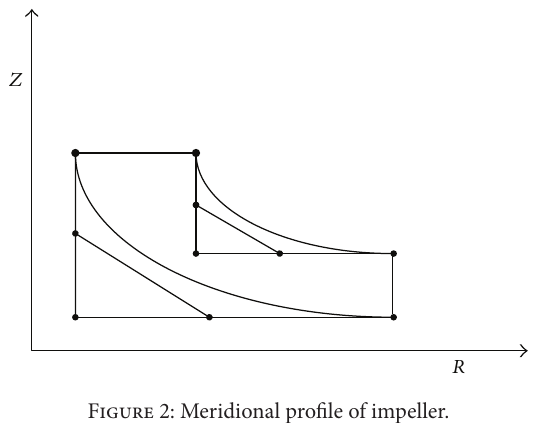
Figure 2: Meridional profile of impeller.